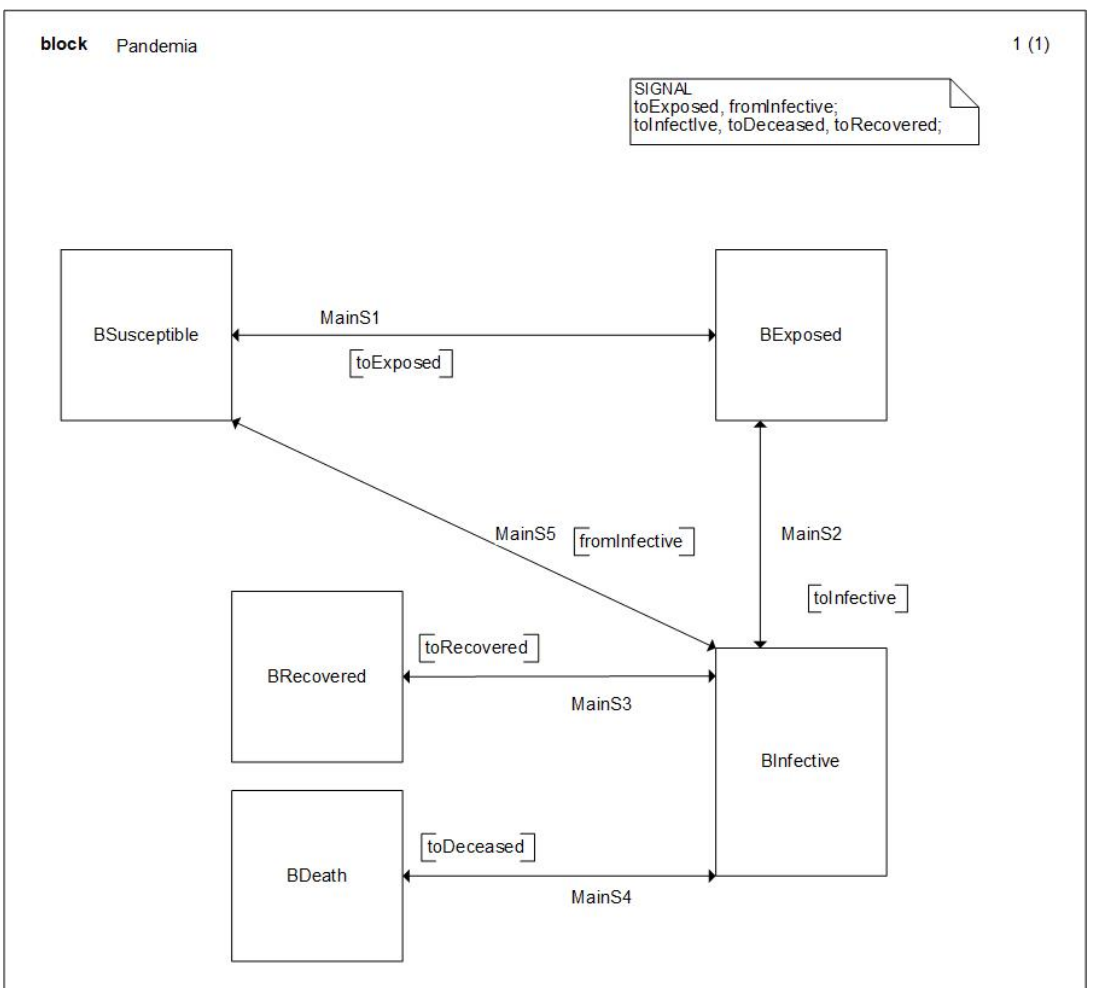
Figure 5. SYSTEM diagram of the SDL conceptual model that represents the pandemic’s evolution.